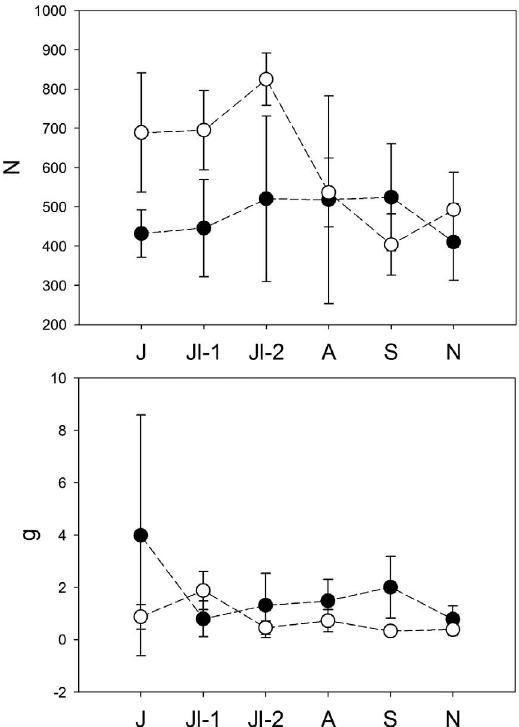
Fig . 3. – Mean abundance (N m -2 ) and mean biomass (wet weight m -2 ) collected at S1 (black circles) and S2 (open circles) from June to November 2003 (J, June; Jl-1, first cruise of July; Jl-2, second cruise of July; A, August; S, September; N, November). Error bars are the standard deviation.